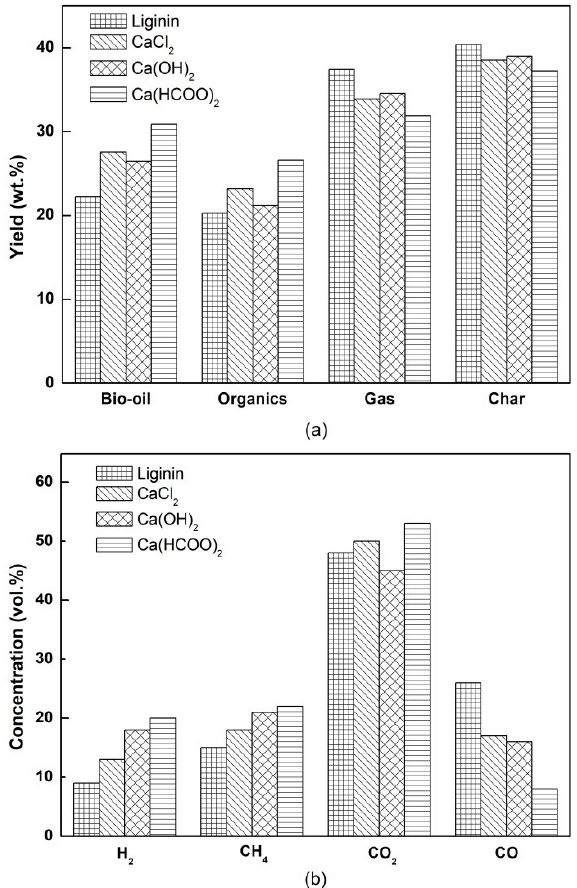
Figure 2. ( a ) Product yields and ( b ) gas composition in the pyrolysis of lignin with and without calcium salt additives. salt